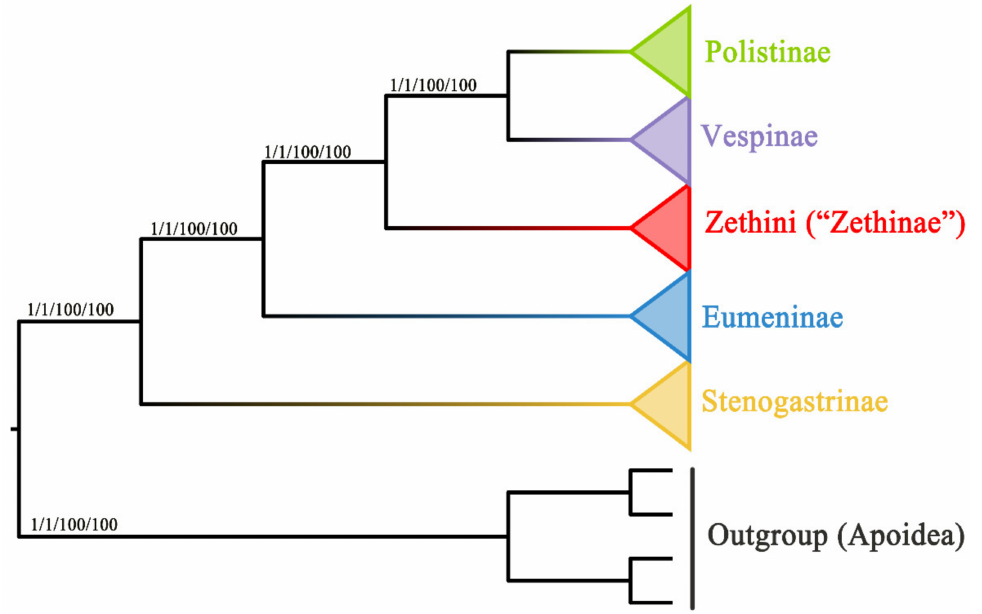
Figure 7. Phylogenetic trees of the Vespidae inferred from PCG and PCGR by ML and BI. Each node shows the Bayesian posterior probabilities (PP)/maximum likelihood bootstrap support (BS)